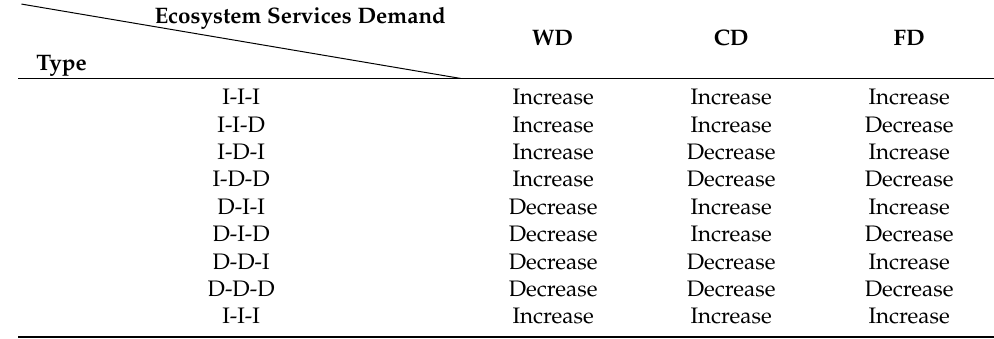
Table 3. Classification rule of changes in ecosystem services demands from 2009 to